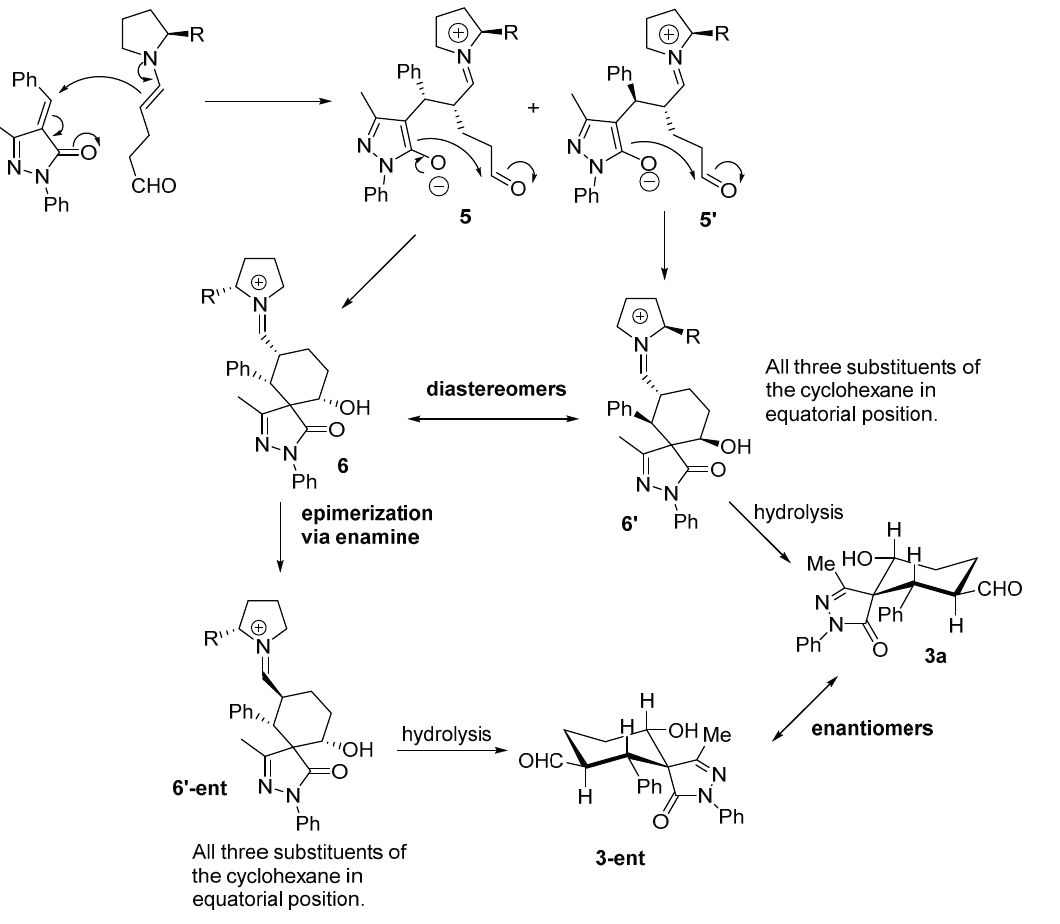
Figure 4. Plausible explanation for the low enantioselectivity